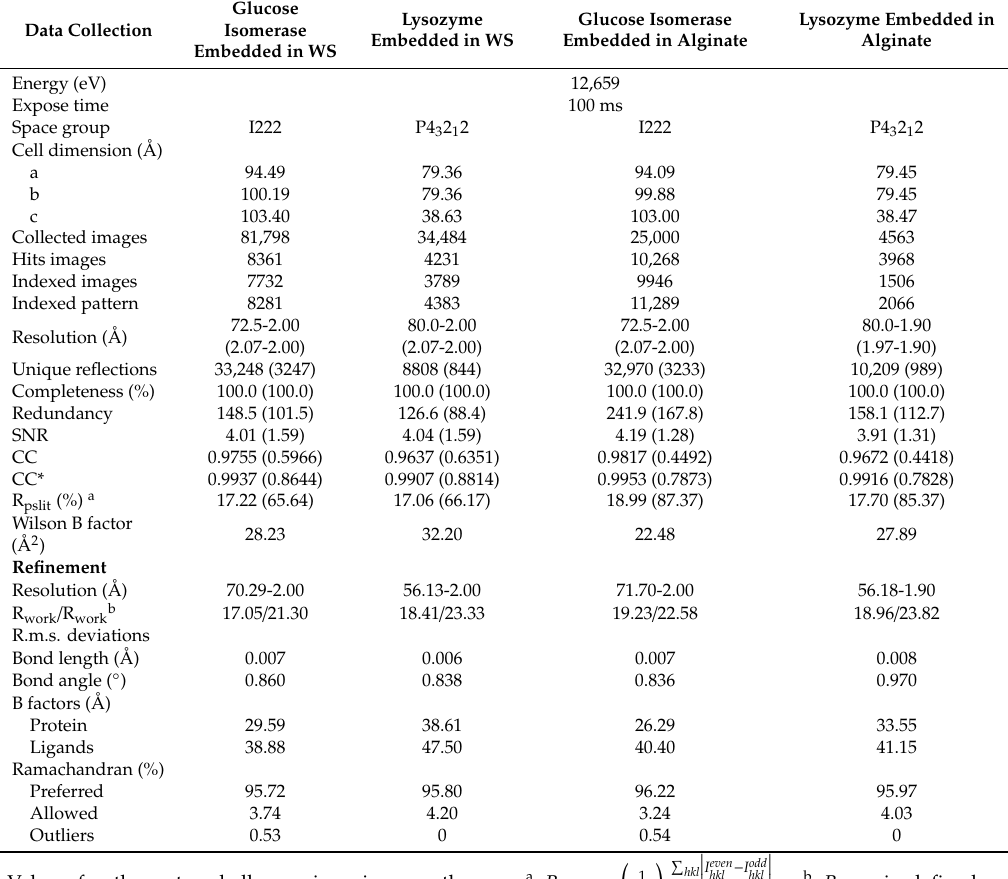
Table 1. X-ray data collection and refinement